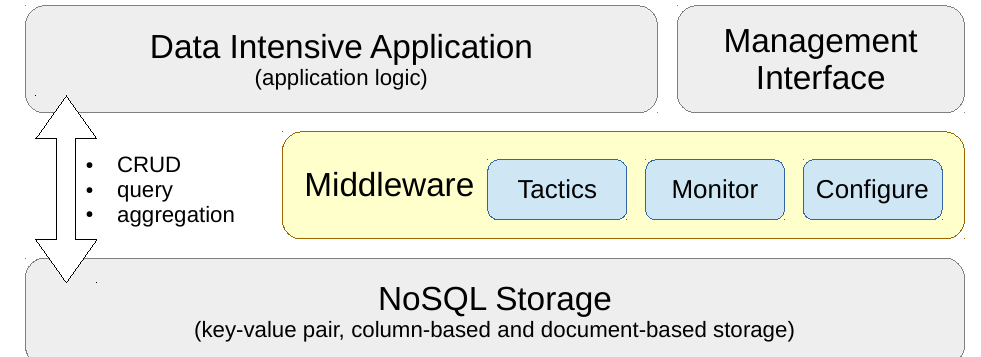
Figure 1. Performance and Scalability Tactics Architecture (PaSTA) middleware with reconfiguration layer.